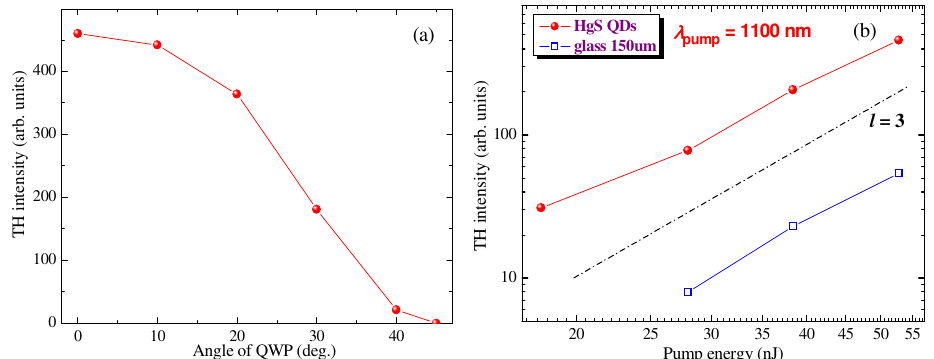
Figure 9. Polarization and intensity dependencies of TH yield from the samples. ( a ) Variation of the TH yield on the rotation angle of the quarter-wave plate (QWP) placed in front of the focusing lens. At the 45° rotation of QWP corresponding to the circular polarization of the fundamental beam, the TH emission was not observed. ( b ) TH intensity as a function of the pump radiation energy. Red diamonds and blue, empty squares show the I TH ( I PP ) dependencies in the case of film + plate and pure plate, respectively. The black, dot-dashed line corresponds to the expected cubic slope of these dependencies ( l = 3; I TH ¥ I PP3 ).